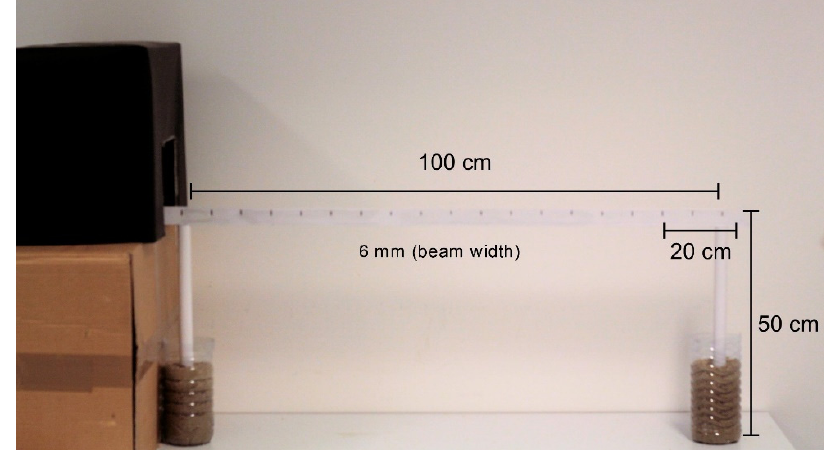
Figure 10. Image of the apparatus used for beam walking test.